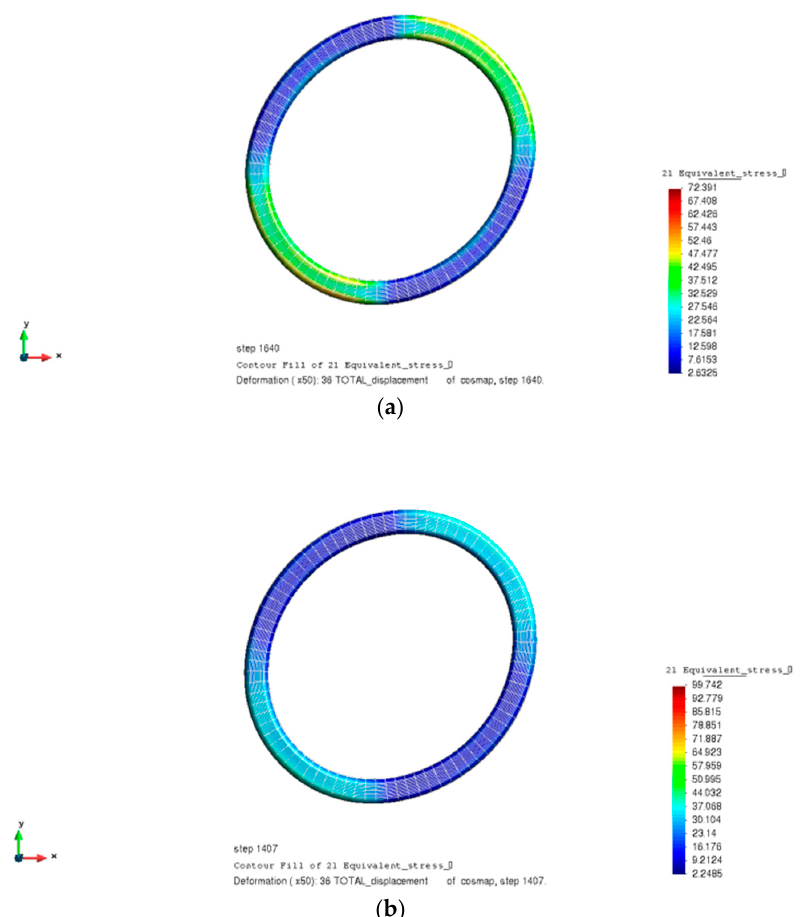
Figure 15. Residual stress for orthogonal symmetrical heat transfer, external orthogonal symmetrical and internal axial symmetry heat transfer (50× deformation as a reference). ( a ) Residual stress for orthogonal symmetrical heat transfer; ( b ) residual stress for external orthogonal symmetrical and internal axial symmetry heat transfer.